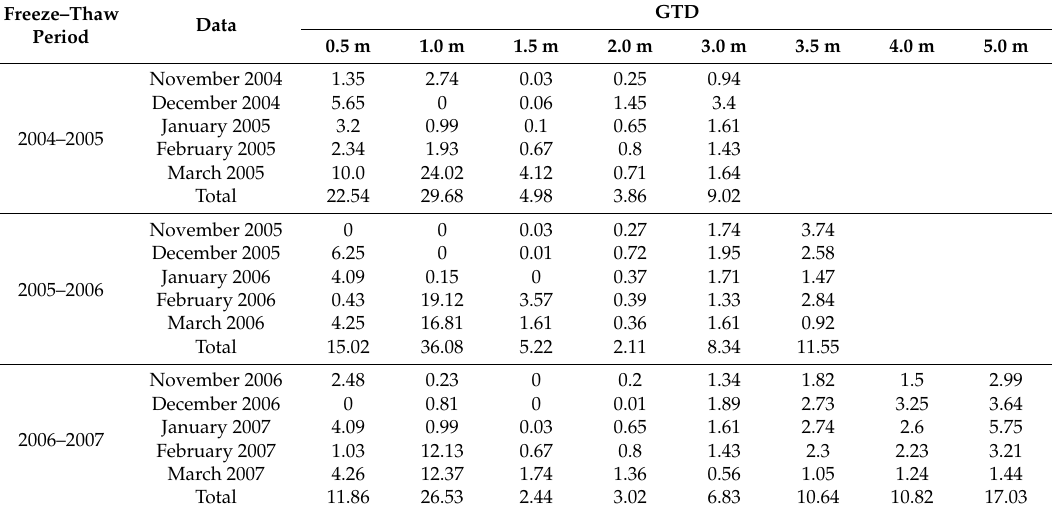
Table 8. Recharge to phreatic water with fine sand during freeze–thaw periods. Unit: Millimeters. Freeze–Thaw